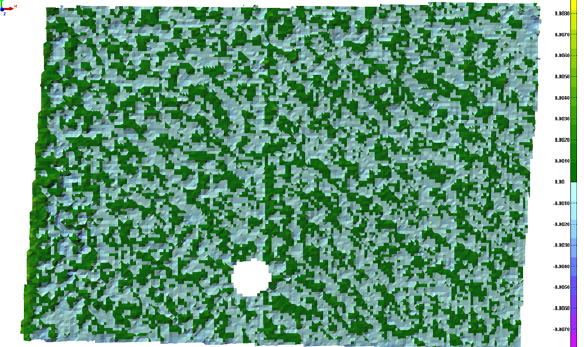
Figure 5. Color-coded deviation of the raw range map from the filtered one. The color map is the same of Fig. 3. The error span is clearly reduced and the error appears more randomly distributed over the